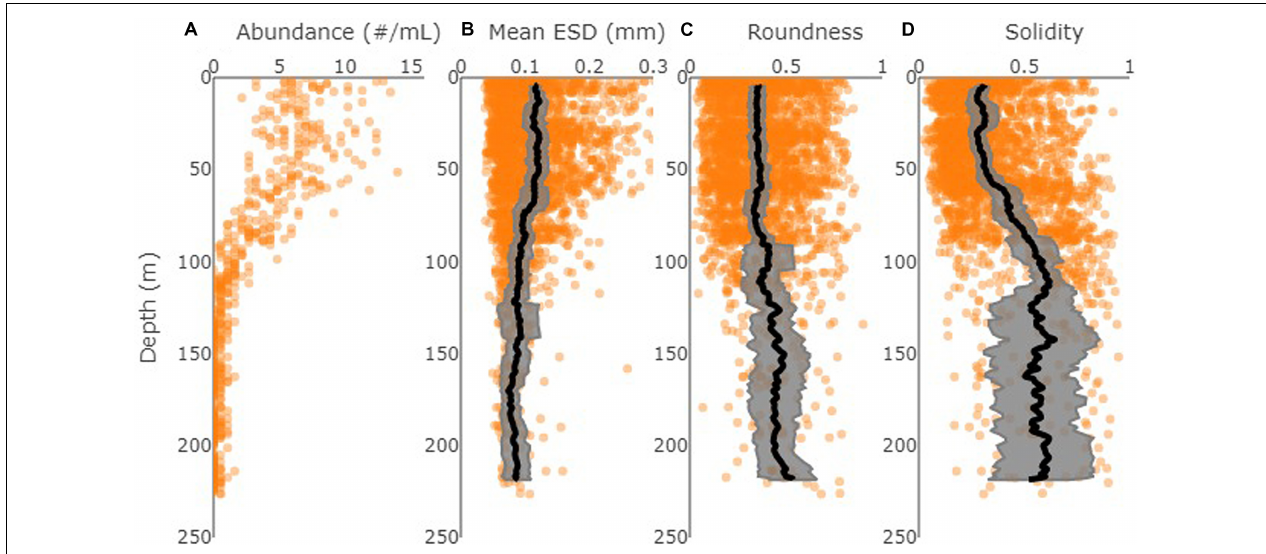
FIGURE 3 | Depth profiles of particle statistics from profile DY086-034 near South Georgia based on Otsu, showing (A) number of particles (per mL calculated for each image), (B) particle ESD (in mm), (C) roundness, and (D) solidity. Black lines show running mean ( n = 11) for 1-m binned data. Gray envelopes show the corresponding standard